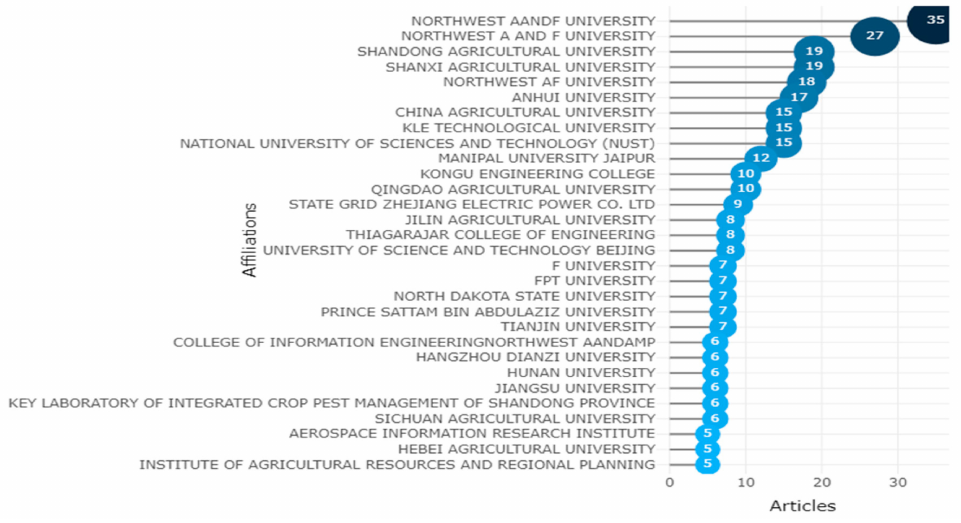
Figure 17. Affiliation Statistics of Apple Leaves Diseases. Data access information source: http: //www.scopus.com (accessed on 14 September 2022).